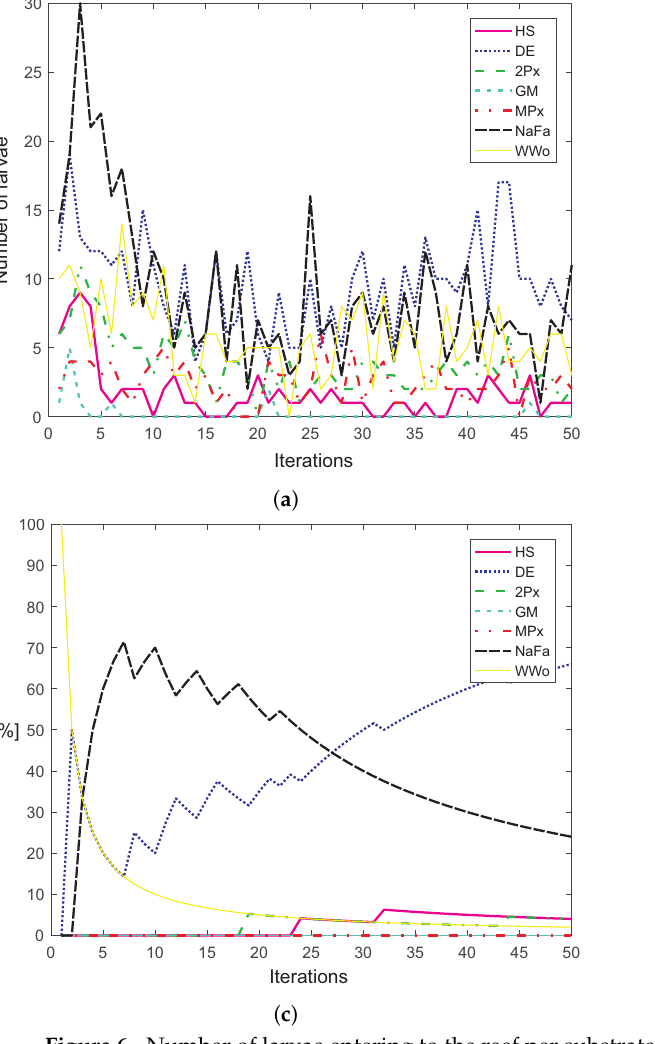
Figure 6. Number of larvae entering to the reef per substrate for the linear ( a ) and nonlinear ( b ) cases, and ratio of times that each substrate generates the best larva in the linear ( c ) and nonlinear ( d ) cases when the height H is